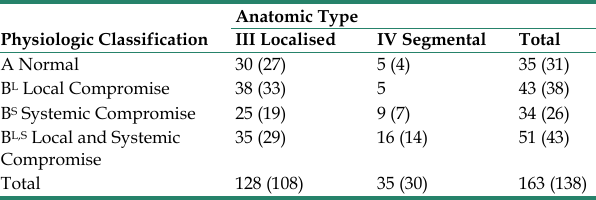
Table 2. Distribution of Cierny-Mader anatomic type and physiologic classification in the cohort of 154 cases with minimum one-year clinical follow-up.